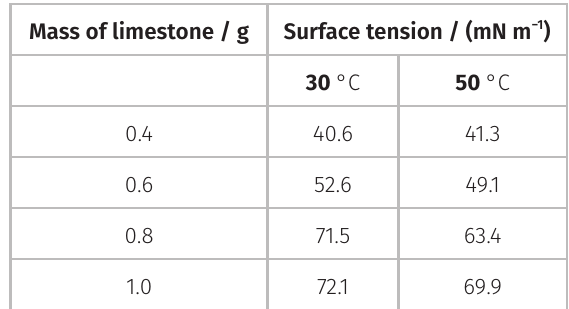
Table II. Average surface tensions of the SCO filtrates obtained after the finite-bath assays at 30 °C and 50 °C.